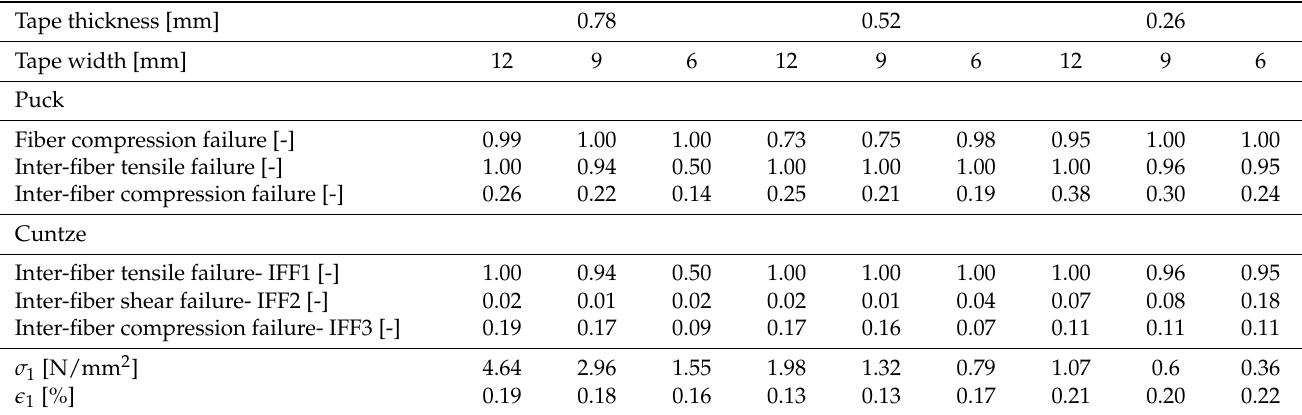
Table 4. Mode effort of the relevant failure criteria according to Puck and Cuntze as well as the corresponding structural stress and structural strain in the x 1 -direction for the different tape configurations at the point of failure.